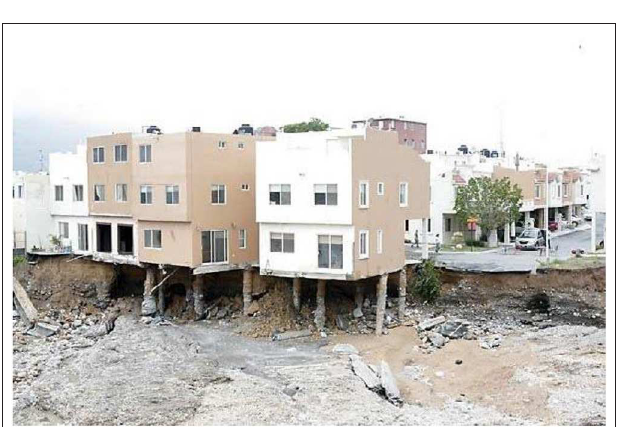
FIGURE 8 | Impacts to Constitucion Avenue. Courtesy from El Norte.